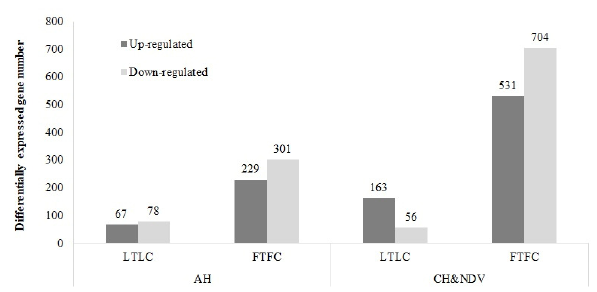
Figure 2. Numbers of differentially expressed gene identified between genetic lines. A false discovery rate (FDR) < 0.05 was used to classify genes as significantly differentially expressed. AH: Acute heat stress; CH&NDV: Chronic heat stress and NDV infection at 2 dpi; FCLC: Fayoumi non-treated vs. Leghorn non-treated; FTLT: Fayoumi treated vs. Leghorn treated.